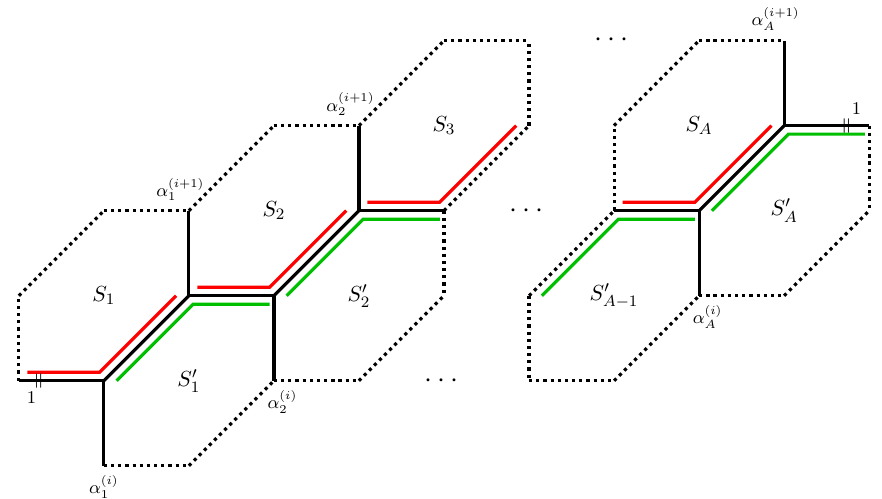
. Red (Green) curves j and (cid:11) ( i +1) 1 ;:::;A 1 ;:::;A